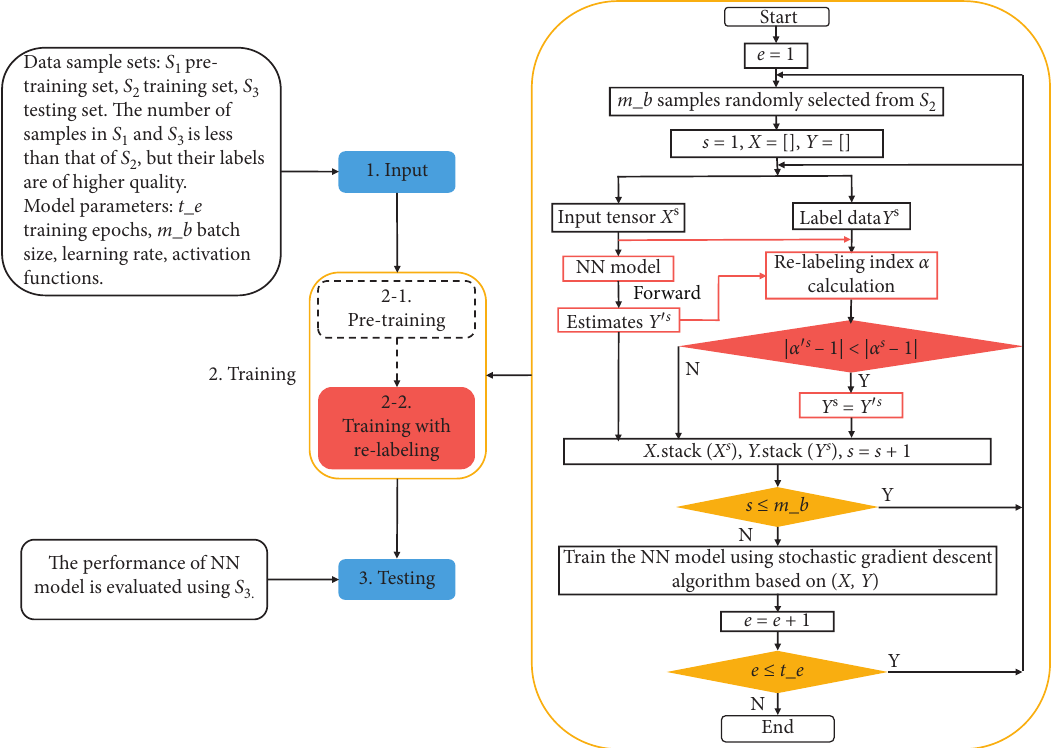
Figure 5: Framework of model training using bootstrapping